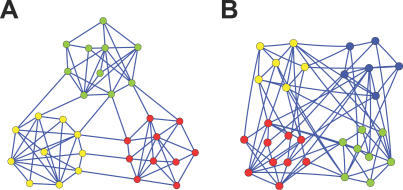
An Example of a Small Network with a Modular Structure (A) and Its Randomly Rewired Network (B)Different colors show different modules separated by Guimera and Amaral's algorithm [28]. The modularity is 0.5444 for the network in (A) and 0.2838 in (B), and the scaled modularity is 15 for the network in (A) and 0 in (B).